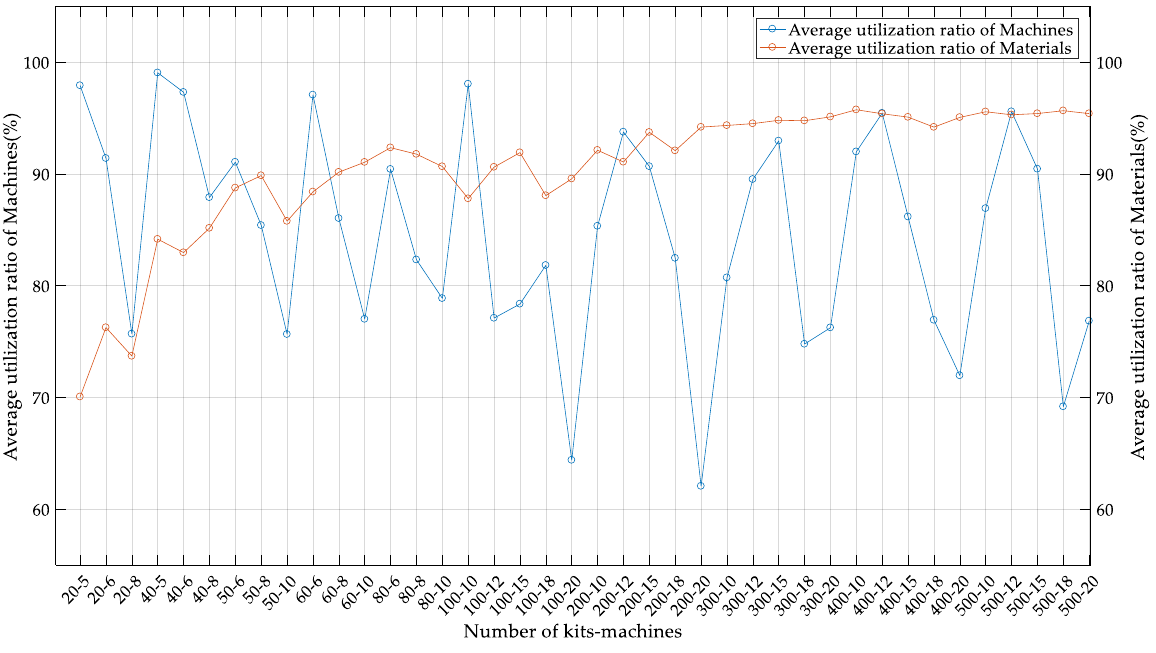
Figure 14. Average utilization of machines and materials in the first stage.